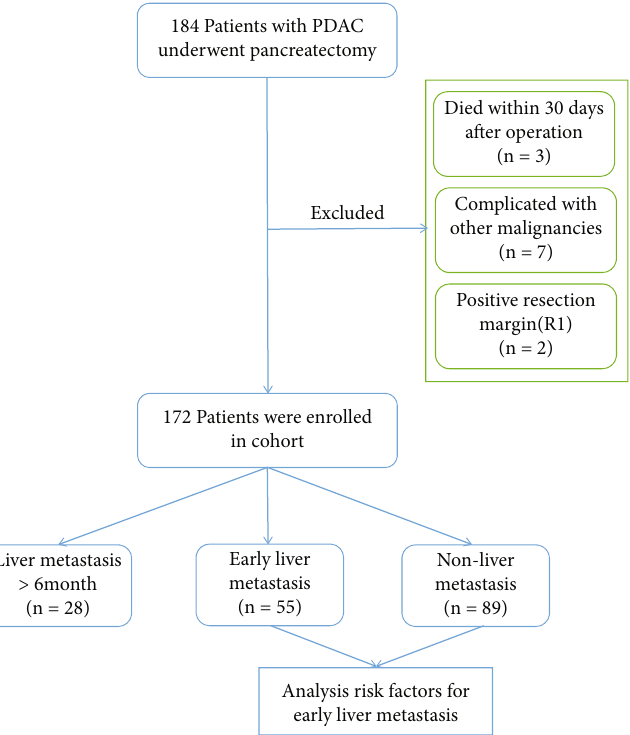
Figure 1: Exclusion criteria and grouping